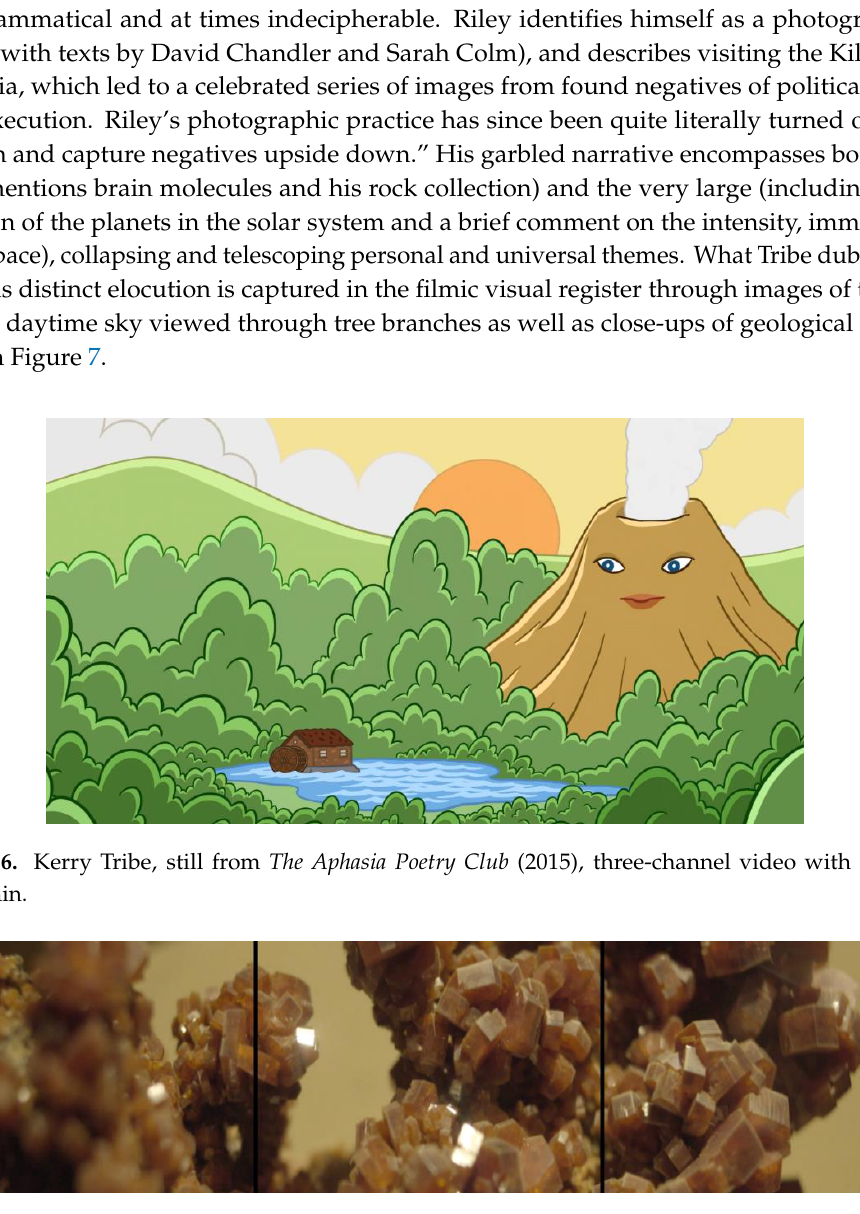
Figure 7. Kerry Tribe, still from The Aphasia Poetry Club (2015), three-channel video with sound, 28:27 min.